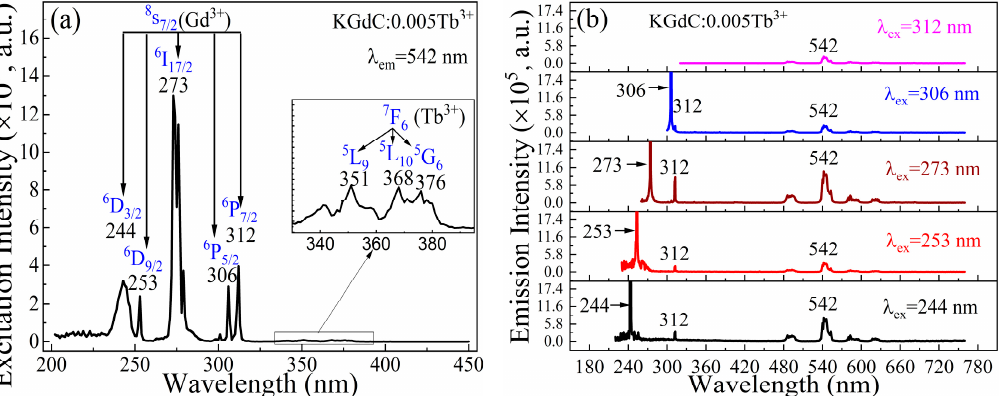
Figure 3. Luminescence properties of KGdC:0.005Tb 3+ : ( a ) Excitation spectrum; ( b ) Emission spectra excited at 244, 253, 273, 306, and 312 nm.